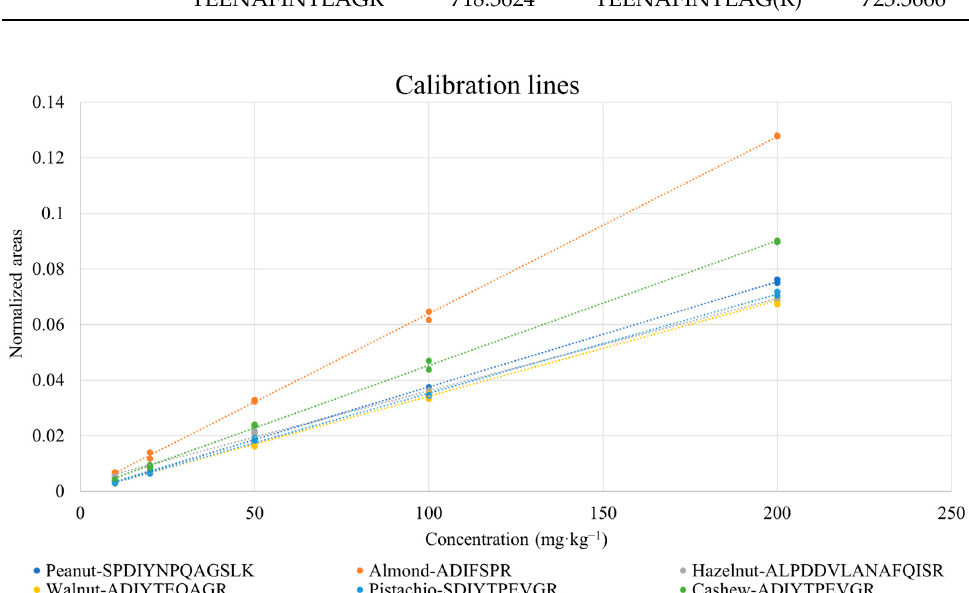
Figure 3. Examples of the calibration lines obtained for selected marker peptides of nuts and peanuts after the analysis of cookie protein extracts corresponding to different concentrations of allergenic ingredients. Table 4. Correlation coefficients and detection (LOD) and quantification limits (LOQ) values ob- tained after calibrations performed for the six allergenic ingredients of interest in the cookie matrix considering specific marker peptides.